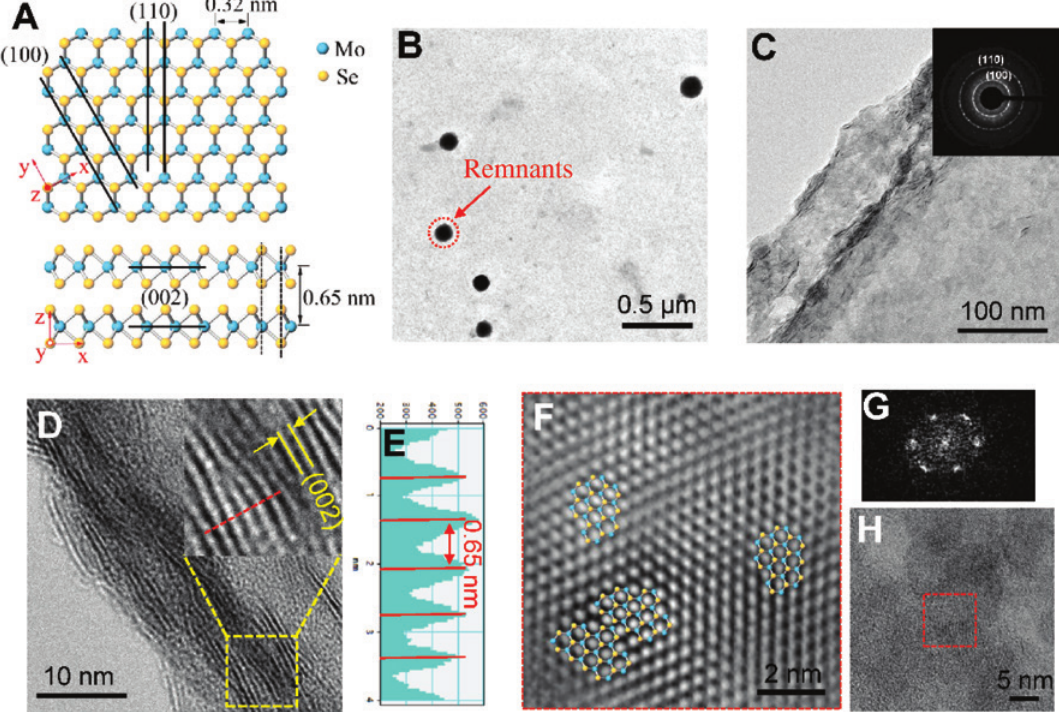
atomic film on a TEM grid. Figure 3: TEM characterization of MoSe 2 (A) Lattice configuration of MoSe with top and side views. Mo atoms are shown in blue and Se atoms are shown in yellow. 2 (B) Low-magnification top-view TEM image of MoSe layers. Black dots were unavoidably produced during the transfer onto the TEM grid, 2 representing the residues (PMMA). (C) Magnified view of the sample with an inset showing the SAED pattern of the polycrystalline film. Some wrinkles are observed on the edge of the film. (D) Typical HRTEM image of the few-layer MoSe film. (E) Line intensity profile of the red 2 dot line drawn in D. (G and F) Corresponding FFT and iFFT images of the region indicated by squares in H,